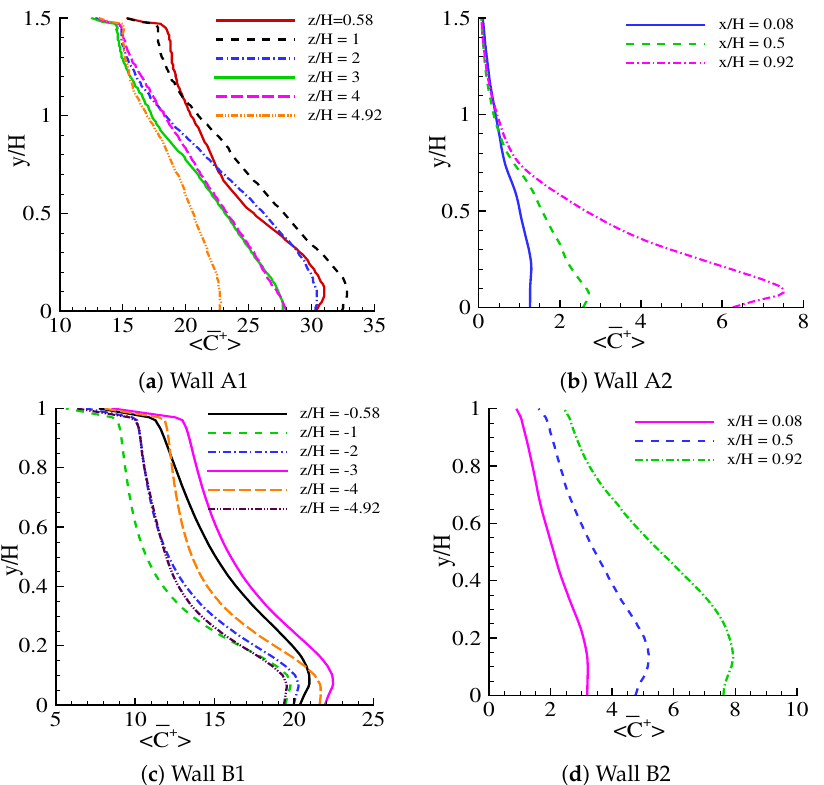
+ (cid:105) data on ( a , b ) walls A and ( c , d ) walls B